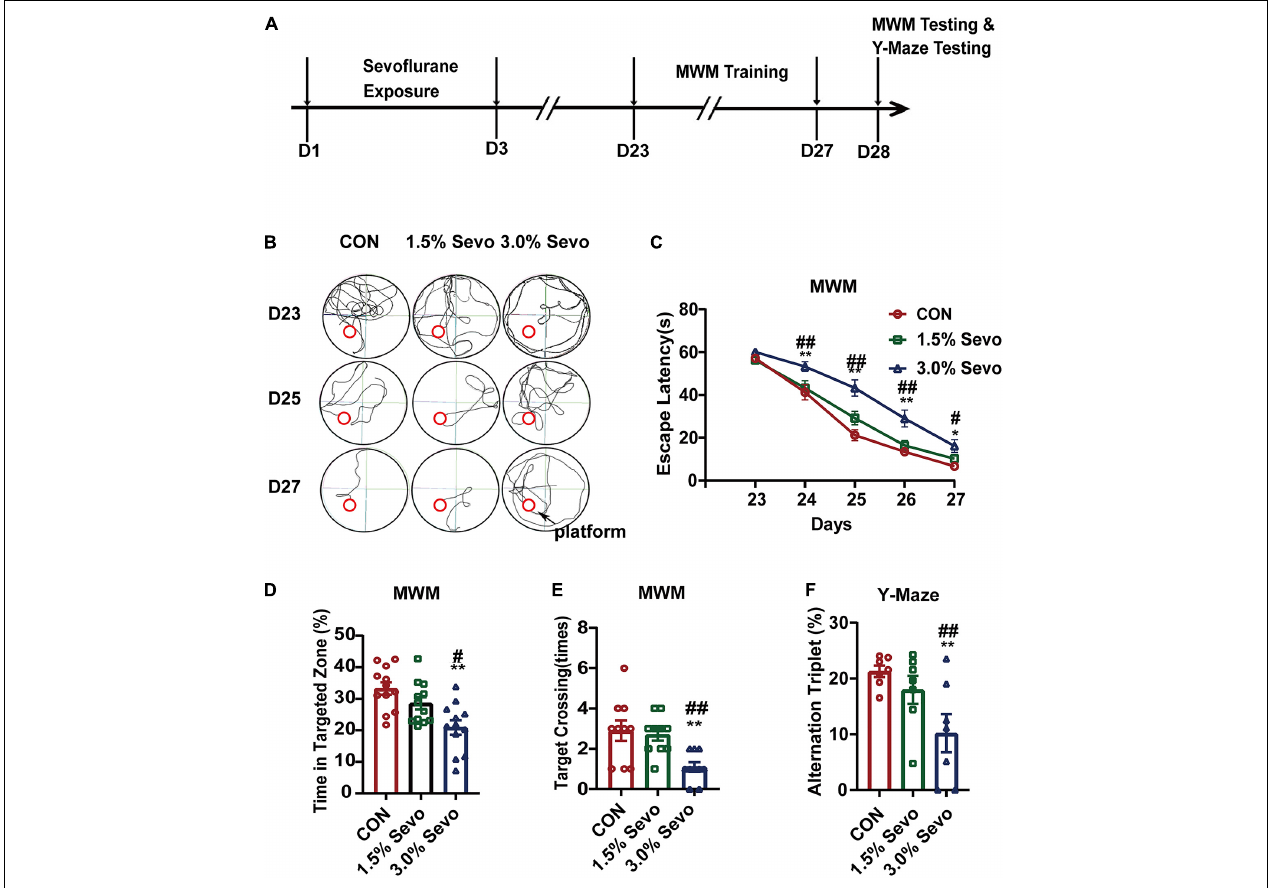
FIGURE 1 | Exposure to 3% sevoflurane induces cognitive impairment in aged mice. (A) Timeline of the MWM and Y-Maze Test experimental procedure. (B) Representative tracks and (C) Escape latency of the MWM during training days. The platform is located in circle region. (D) The percentage of time in targeted zone in testing day. (E) Times of target crossing. (F) Alternation triplet of Y-maze. Values are the mean ± S.E.M. * p < 0.05, ** p < 0.01, compared with the CON group. # p < 0.05, ## p < 0.01 compared with the 1.5% Sevo group ( n = 7/group). D, days of experimental procedure; MWM, Morris Water Maze Test; CON, control group; 1.5% Sevo, 1.5% sevoflurane group; 3.0% Sevo, 3.0% sevoflurane